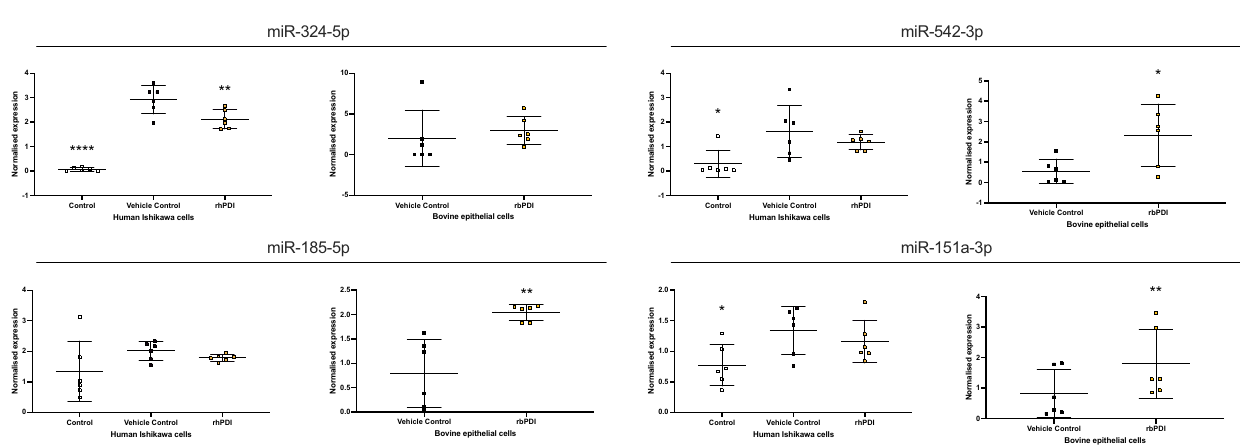
Fig. 4 Regulation of stem lineage miRNAs in human and bovine endometrial epithelial cells treated with hPDI or bPDI, respectively. Expression of stem lineage miRNAs mir-324-5p, miR-542-3p, miR-185-5p, and miR151a-3p in either human (left-hand side of each pair) or bovine (right-hand side of each pair) endometrial epithelial cells ( n = 6 per treatment). Primary bovine endometrial epithelial cells were treated with vehicle control (grey circle), or 1000 ng/ μ L bPDI (orange circle) for 24 h. Human Ishikawa immortalised endometrial epithelial cells were treated with control (open circle), vehicle control (closed circle), or 1000 ng/ μ L hPDI (orange circle) for 24 h. Signi fi cant differences in miRNA expression values determined when p ≤ 0.05 are depicted by an asterisk Bovine epithelial cell culture . The effect of P4 was assessed using cells isolated from tracts in the early luteal phase. The effect of conceptus-derived proteins was assessed in cells isolated from late luteal phase tracts to better mimic events in early pregnancy in vivo. Tracts were staged 63 and cells isolated and cultured as pre- viously described 37 . Brie fl y, the ipsilateral horns were dissected by inserting sterile curved scissors into the uterine lumen and endometrium was washed once with PBS supplemented with 1% GSP (Thermo Fisher Scienti fi c, USA). The endome- trium was dissected from the myometrium in sheets and washed in HBSS (1% GSP) and chopped into 3 – 5mm fragments and digested for 1h at 37 °C in 40mL HBSS (10% BSA, 20mg collagenase II, 4% DNase I, and 100X Trypsin solution). Digested tissue was passed through a 40 μ M cell strainer to isolate epithelial cells, and a 70 μ M strainer to isolate stromal cells. Cells were maintained in T75 fl asks, in